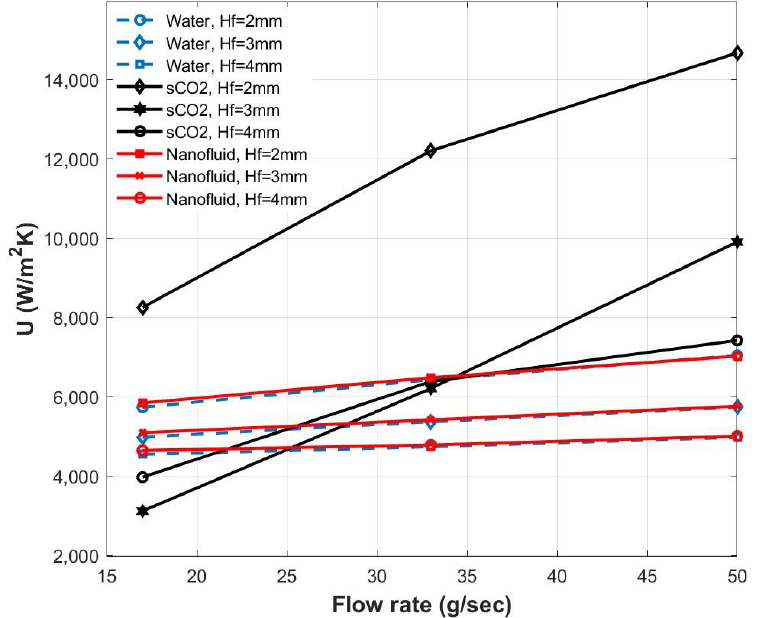
Figure 4. Overall heat transfer coefficient at different flow rates corresponding to different coolants and fin heights.